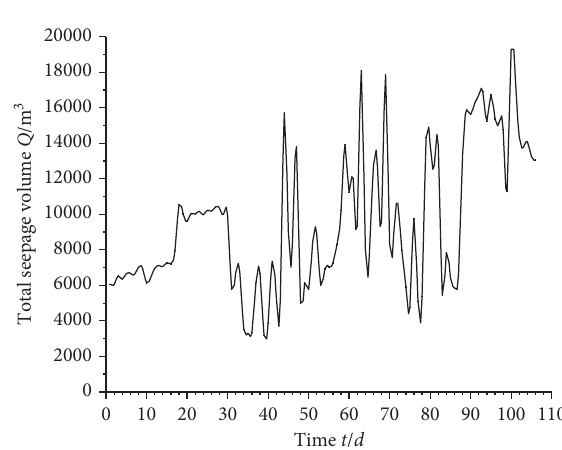
Figure 13: Daily discharge